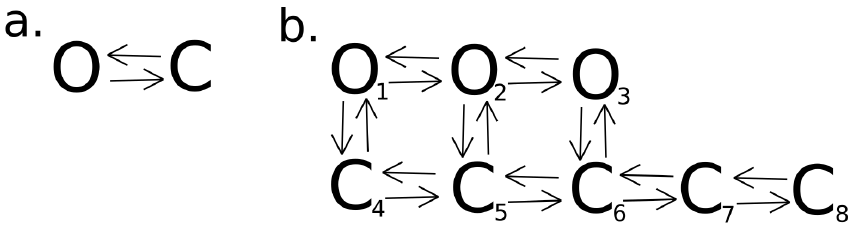
Figure 4. ( a ) A basic two-state Markovian model of channel kinetics. ( b ) A possible representation of BK channel kinetics by 3 open and 5 closed